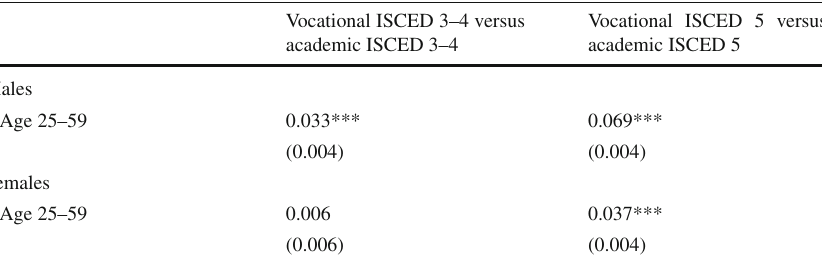
Table11 Averagetreatmenteffectsofvocationaleducationrelativetoacademiceducation,depuratedfrom the effect due to different years of school between treatment and counterfactual. Dependent variable: log years of work. With additional controls for years of schooling. Source : Calculations based on PIAAC